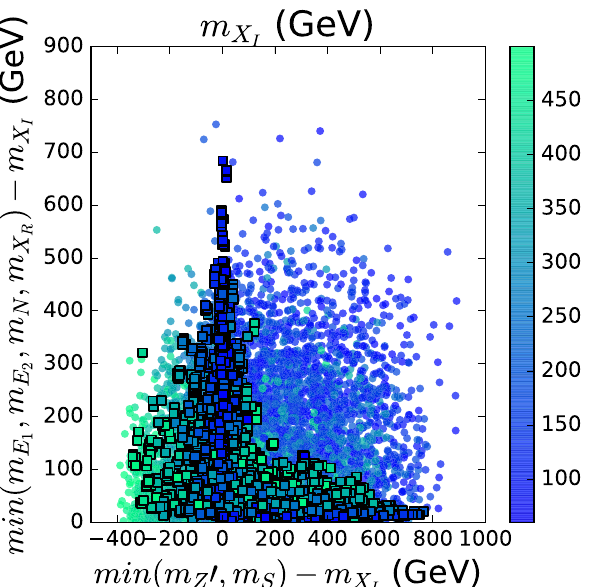
Fig. 6 All samples satisfy the constraints of “pre ( g − 2 ) μ ”, the dipho- ton signal data of the 125 GeV Higgs, and muon g − 2. The squares and circles are allowed and excluded by the DM relic density respectively. The varying colors indicate the values of m X